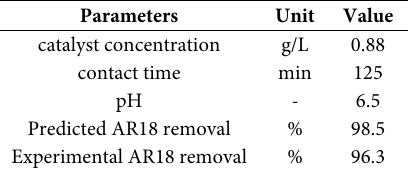
factor, and their interactions on the degradation of AR18. The optimum conditions predicted by the model were the catalyst concentration at 0.88 g/L, pH at 6.5, and contact time in 125 min. The predicted and actual removal of dye were 96.3% and 98.5%, respectively. The removal of COD after 125 min was 53% indicating the notable performance of photocatalyst in mineralization of AR18.